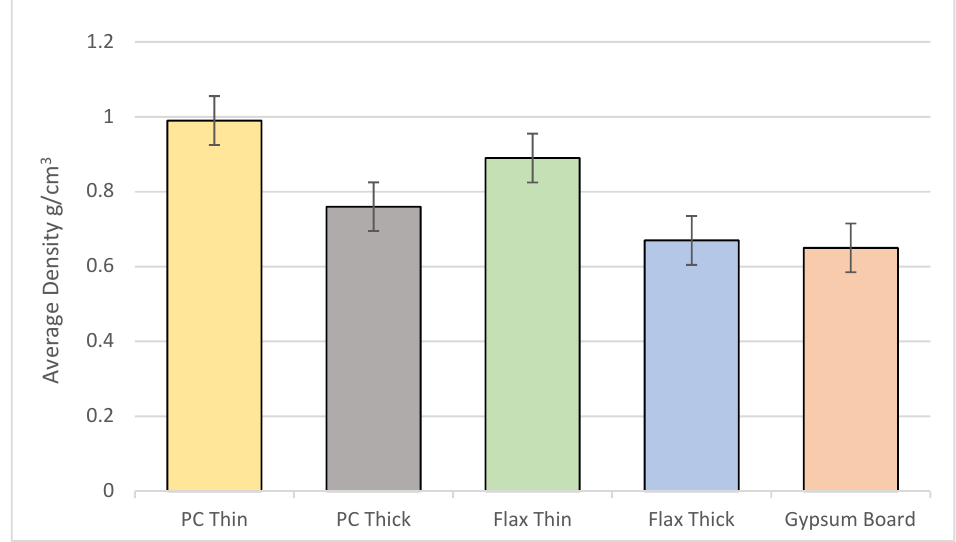
Figure 10. Average densities of honeycomb structures.